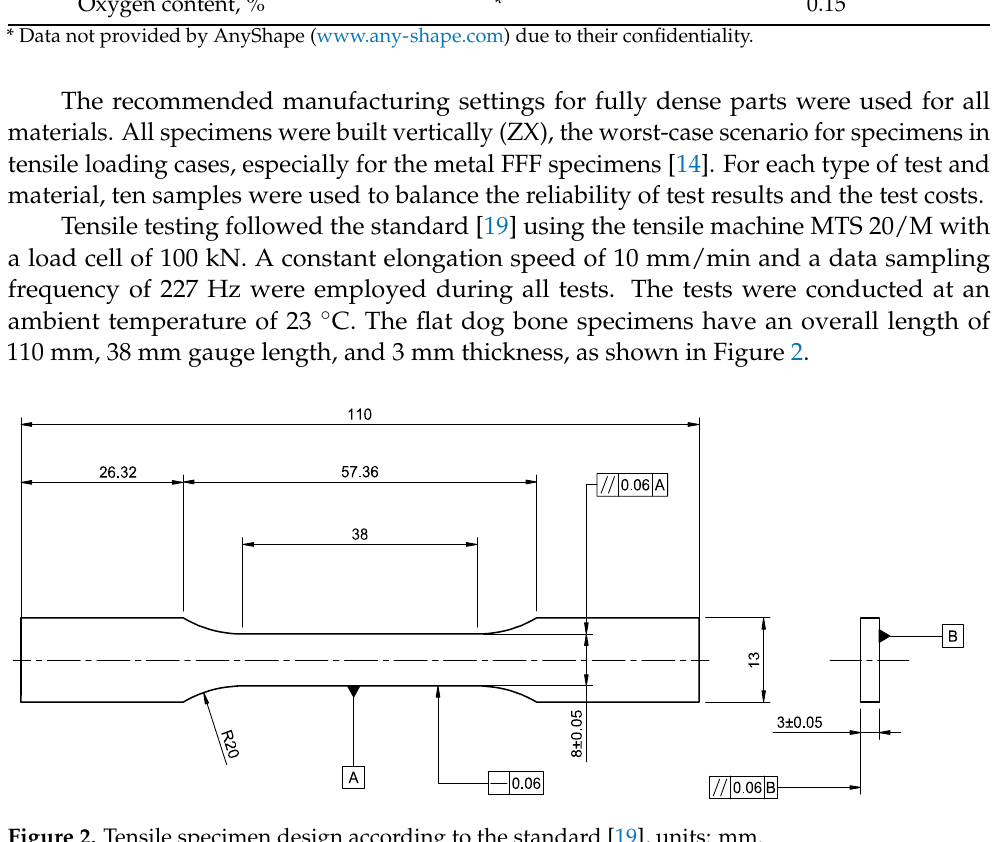
Figure 2. Tensile specimen design according to the standard [19], units: mm.